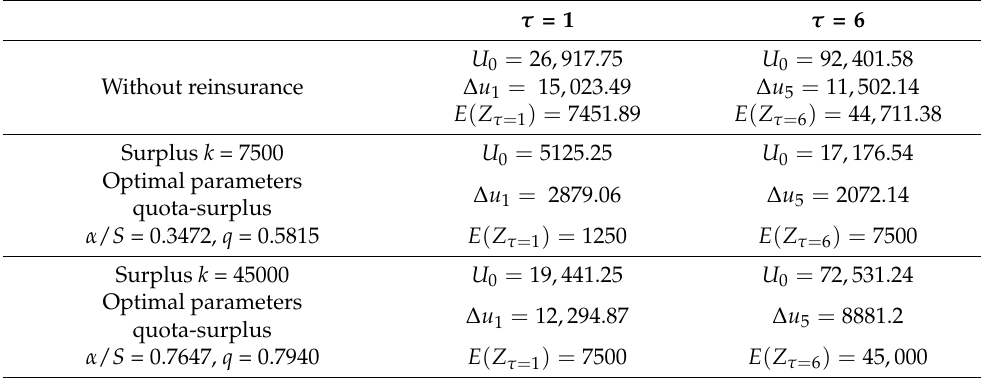
Table 13. Example savings in the initial reserves without and with reinsurance whilst maintain- ing